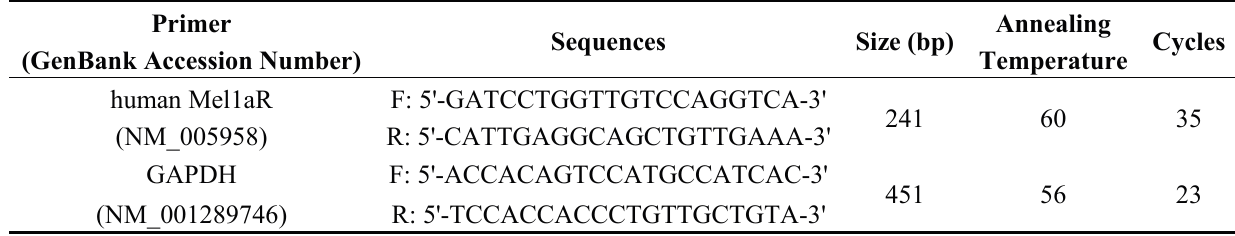
Table 1. Oligonucleotide primers used in